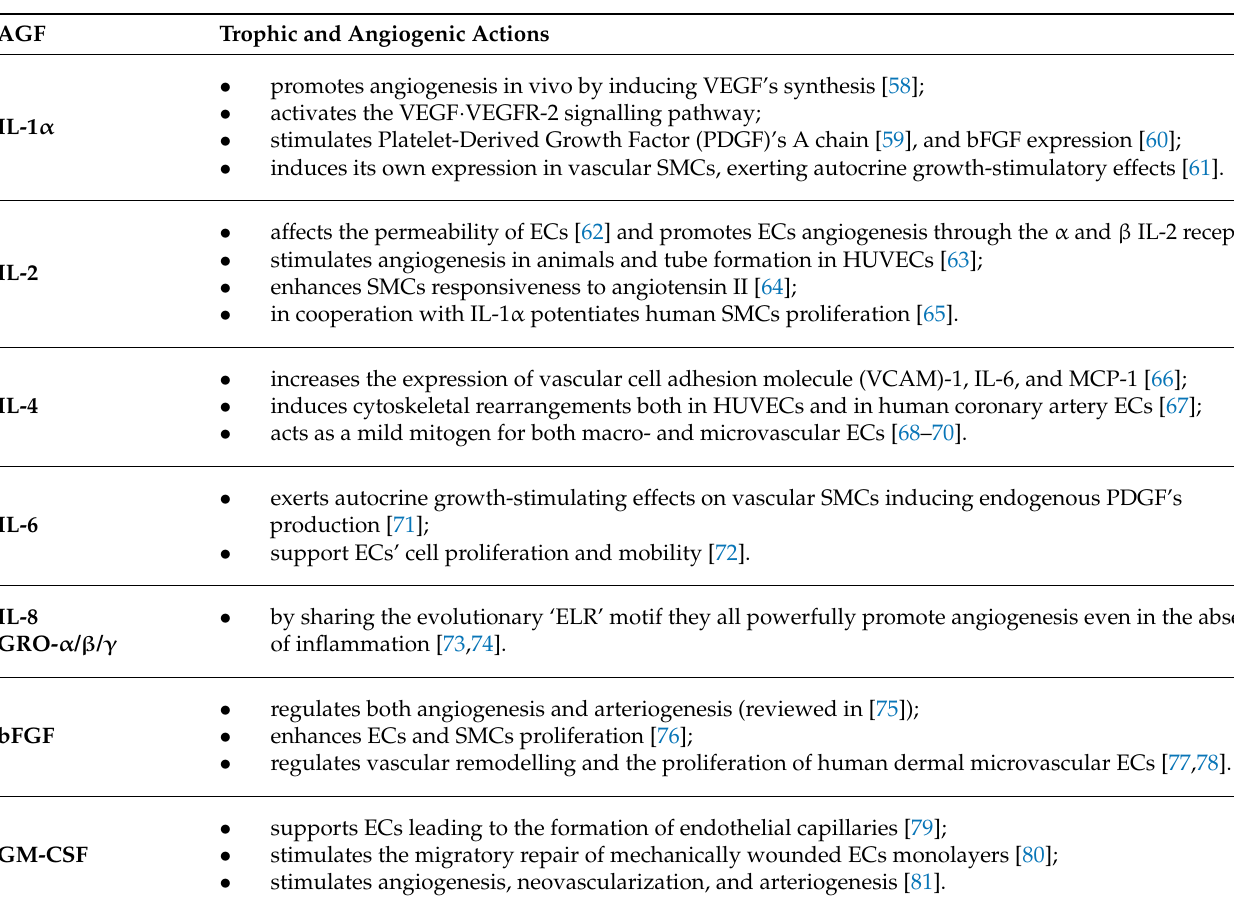
Table 2. The main trophic and angiogenic features of each of the enriched AGFs conveyed by the exosomes released from 3D-SFnws-adhering